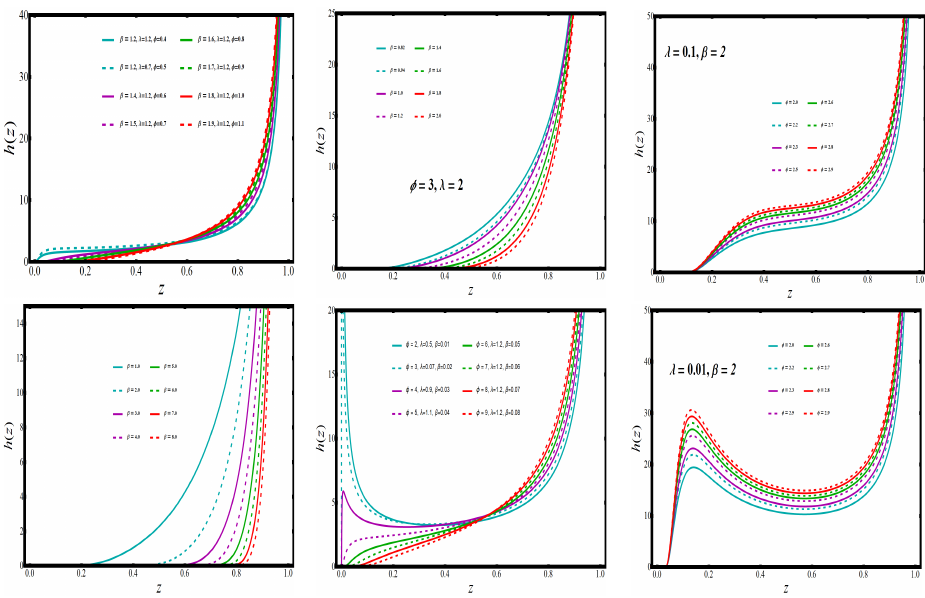
Fig. 2. Variations of hrf of the HLUG-TI for di⁄erent parameter values. Figure 2. Variations of HRF of the HLUG-TI for different parameter values.